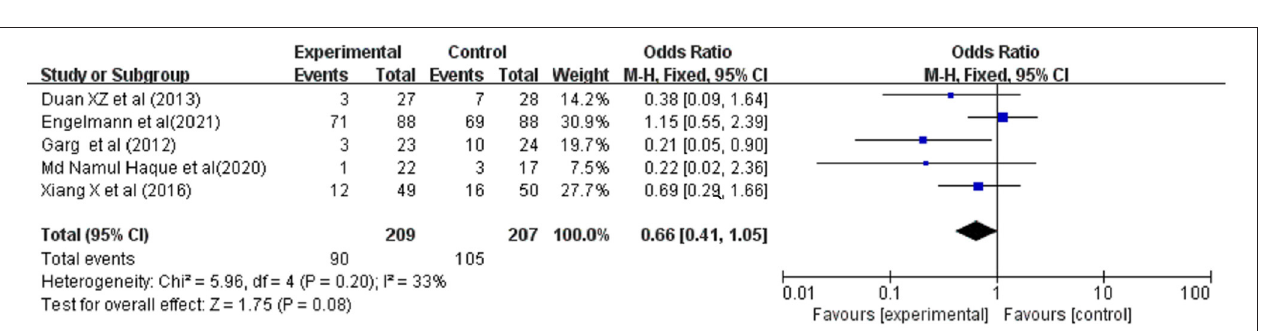
FIGURE 5 | Pooled estimate rate for infection between patients with ACLF. Treated by G-CSF and